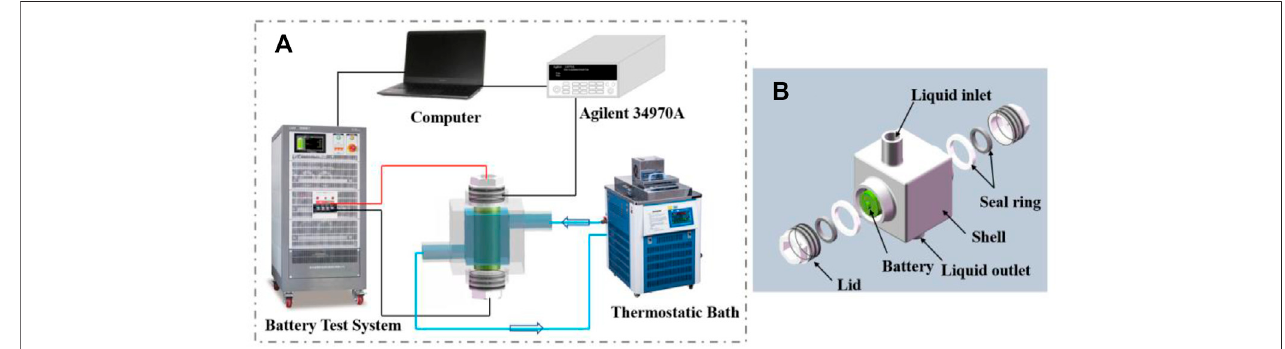
FIGURE 1 | Battery test system (A) and the structure of the single-battery pack (B) .